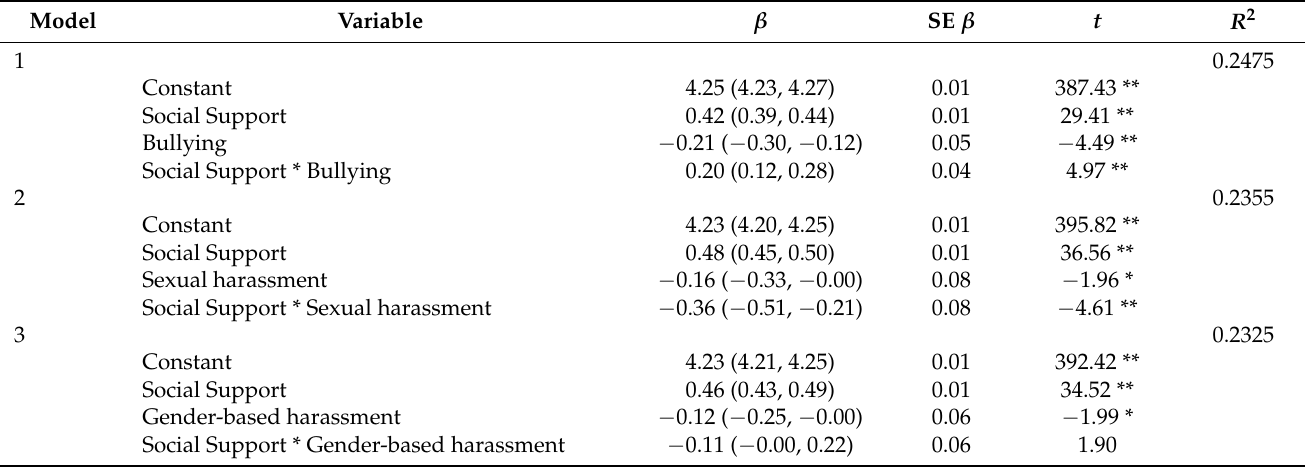
Table 5. Linear models of predictors of job